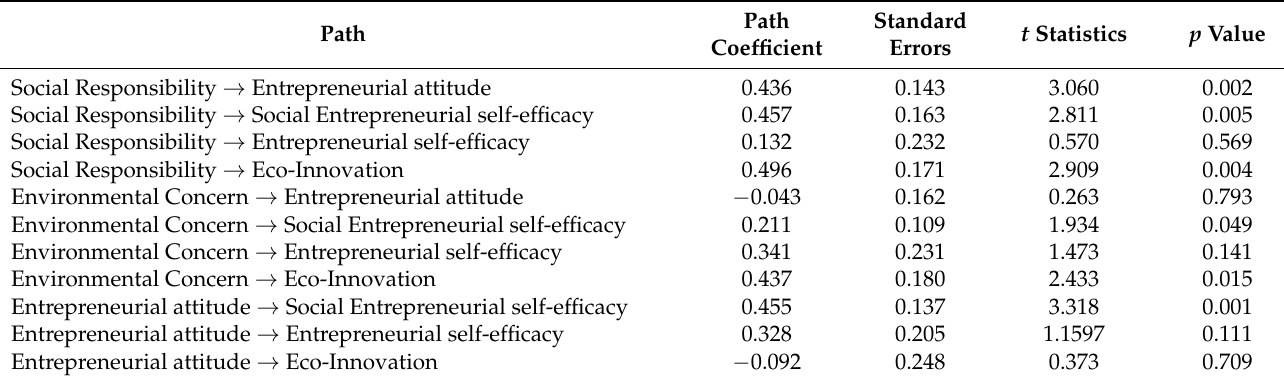
Table 2. Structural Model Assessment.